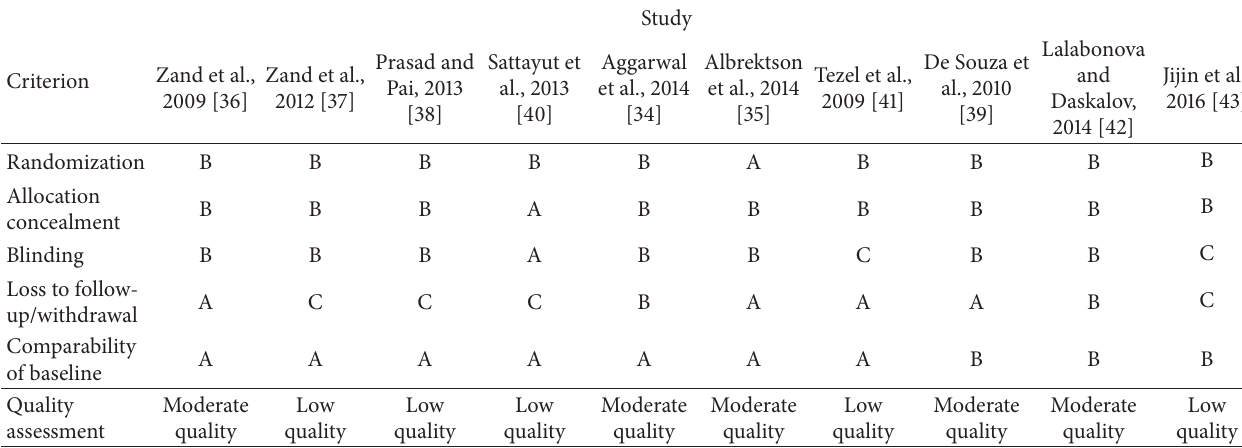
Table 2: Quality of the included